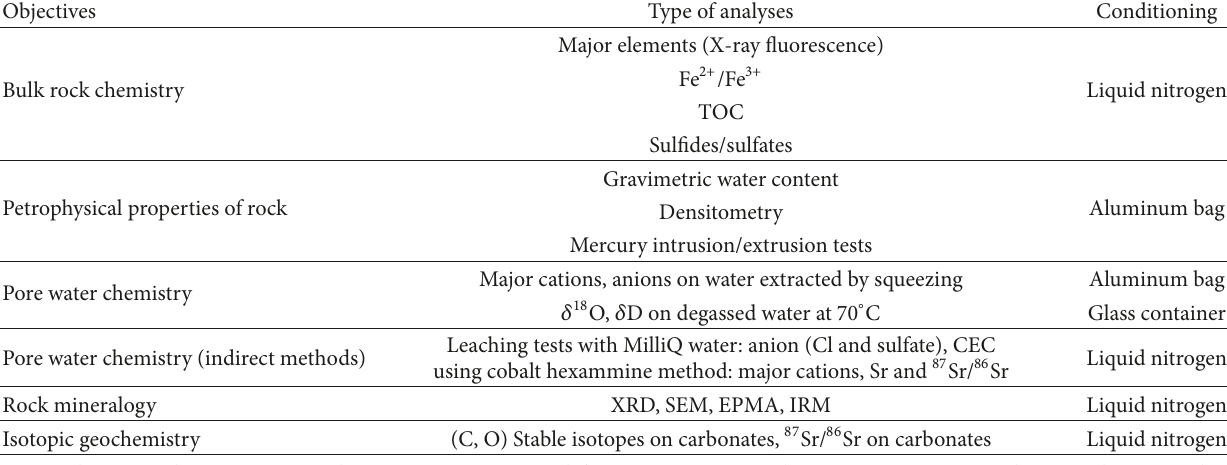
Table 1: Types of characterization, analytical methods, and conditioning used for each type of